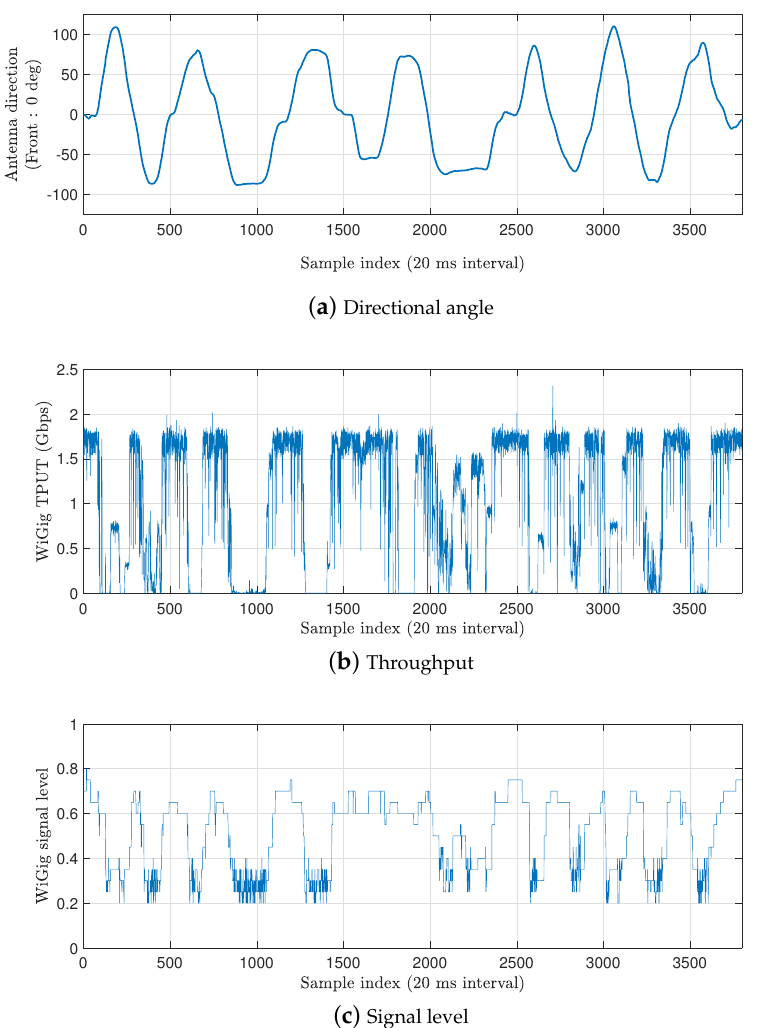
Figure 3. Changes in the directional angle, throughput, and signal level for WiGig with